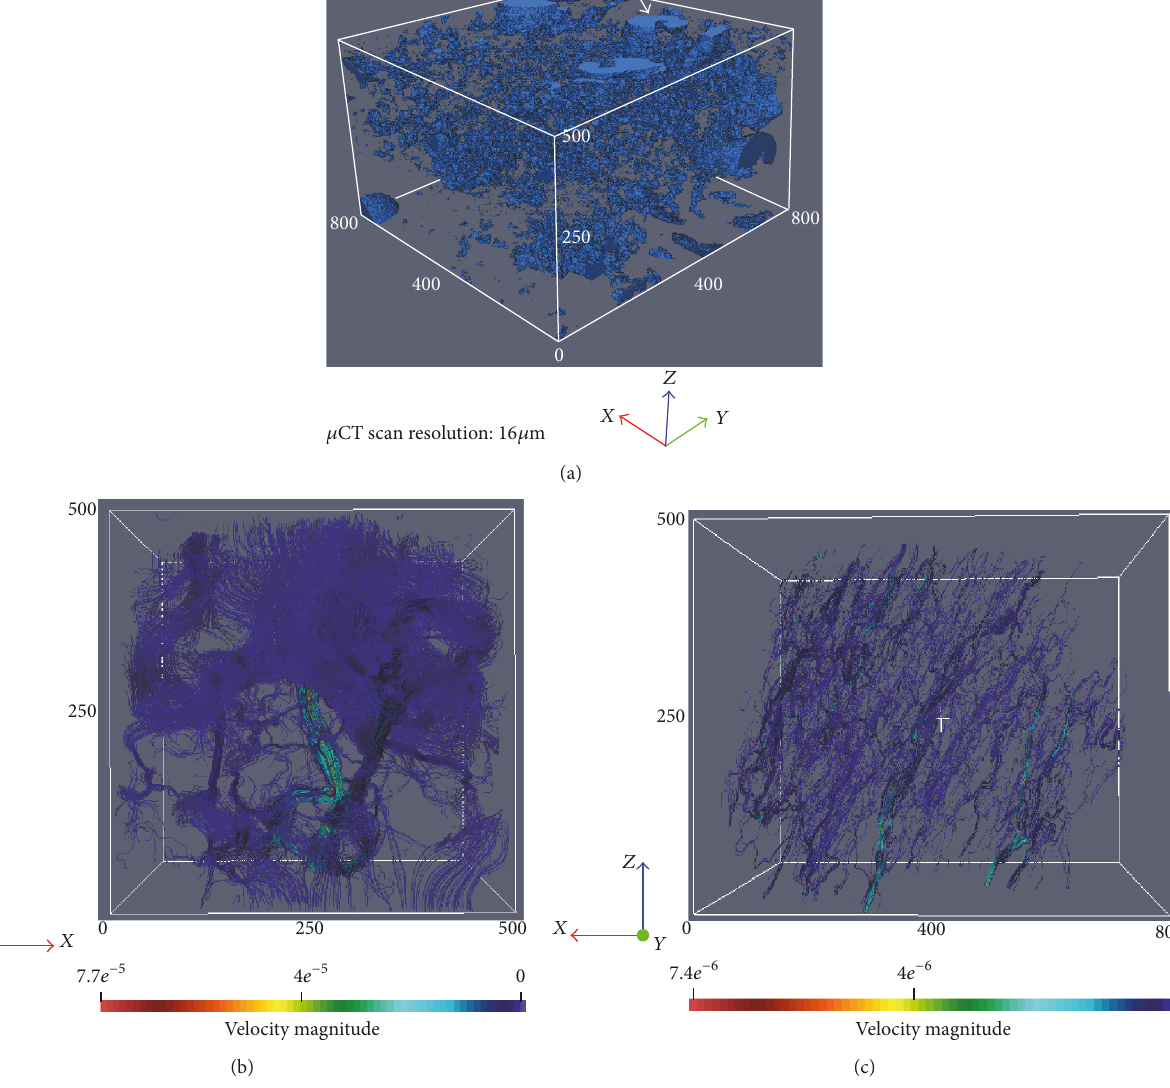
Figure 15: (a) Pore network volume rendering of a sample from the subhorizontal facies (800 by 800 by 500 pixels). The majority of the pores are aligned horizontally. Notice that some gastropod molds are present (see arrows). (b) 3D streamline velocity distribution within a sample from the reed facies, with preferential flow in 𝑧 direction, along vertical tubes, from 𝑧 = 0 to 𝑧 = 500 pixels. (c) 3D streamline velocity distribution within a sample from the waterfall facies, with preferential flow in 𝑧 direction from 𝑧 = 0 to 𝑧 = 500 pixels. The velocity magnitude is given in nondimensional lattice